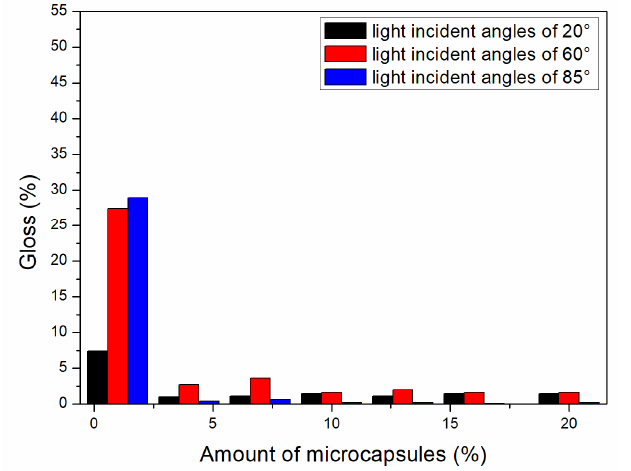
Figure 4. Effect of microcapsule content with the ratio of core materials to shell material in mass of 0.75 on gloss of coating film.